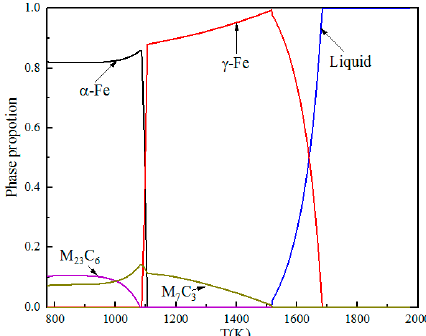
Figure 2. Phase equilibrium diagram of the steel calculated using Thermo-Calc software (M represents metallic element atom; C represents carbon atom).